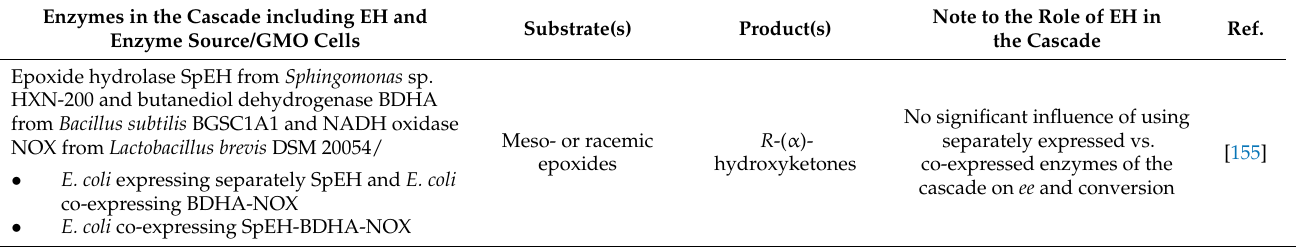
Table 4. Examples of epoxide hydrolases in the whole-cell enzyme cascades and their role in the